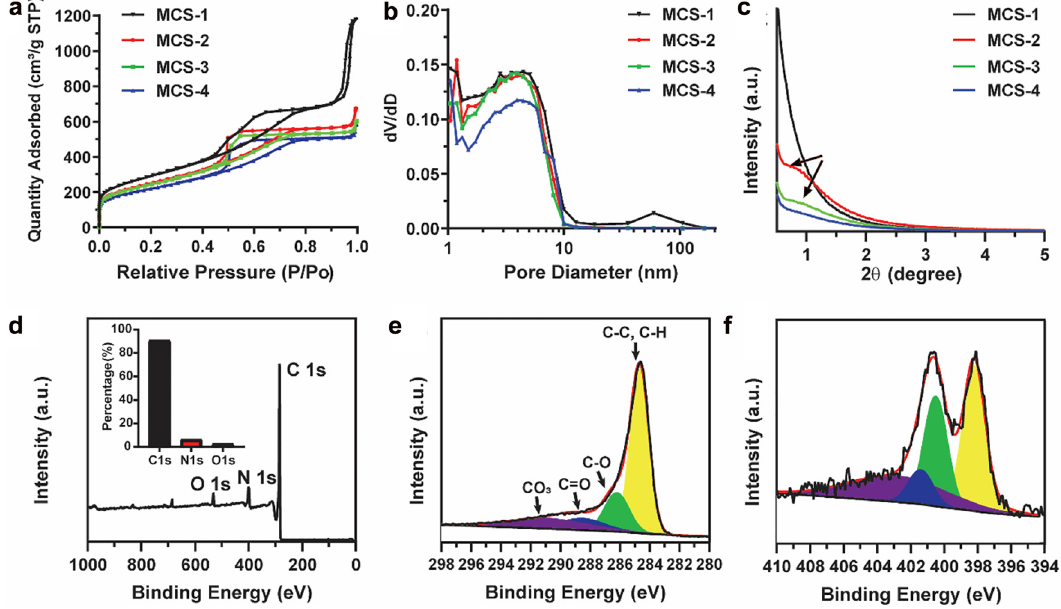
adsorption–desorption isotherms (a), pore size distribution curves (b) and small angle X-ray diffraction patterns (c) of MCS-1, Figure 3: N 2 MCS-2, MCS-3, and MCS-4. XPS of MCS-3 nanoparticles: The survey spectrum (d), high-resolution spectra of C1s (e) and N1s (f). The inset in (d) is the corresponding content of each